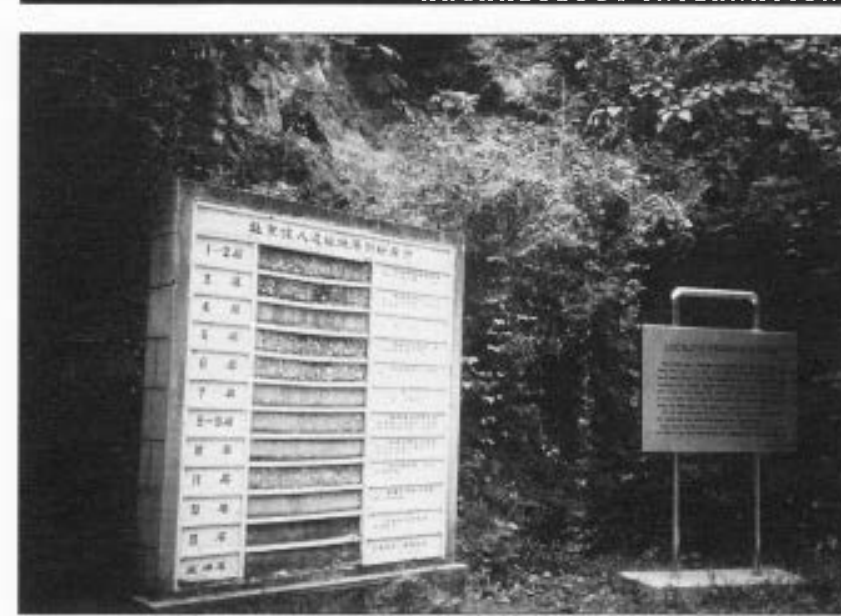
Figure 2 Zhoukoudian, locality 1 : visitor information signs; atrighta recent {1995) sign in English, at left a 30-year old sign in Chinese that incorporates samples of the main strata from the key stratigraphic